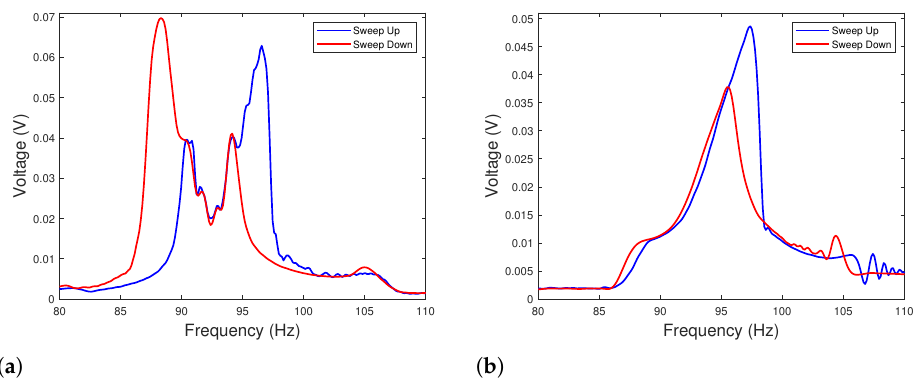
Figure 4. ( a ) Frequency response with optimal parameters ensuring the activation of the internal = 12.74 mm and d ∗ = 35 mm) around the 1st resonance frequency resonance phenomenon ( d ∗ 2 1 (IR case) ( R ∗ em = 7 Ω / ¨ Y = 0.7 g ) ; ( b ) frequency response away from internal resonance condition ( d 1 = 50 mm and d 2 = 50 mm) around the 1st resonance frequency (NIR case) ( R ∗ em = 7 Ω / ¨ Y = 0.7 g )